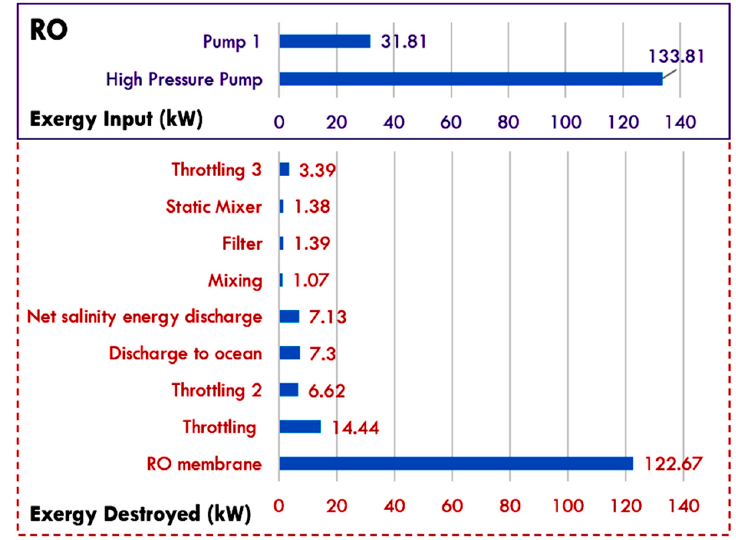
Figure 6. Exergy balance of a reverse osmosis unit receiving brackish water.